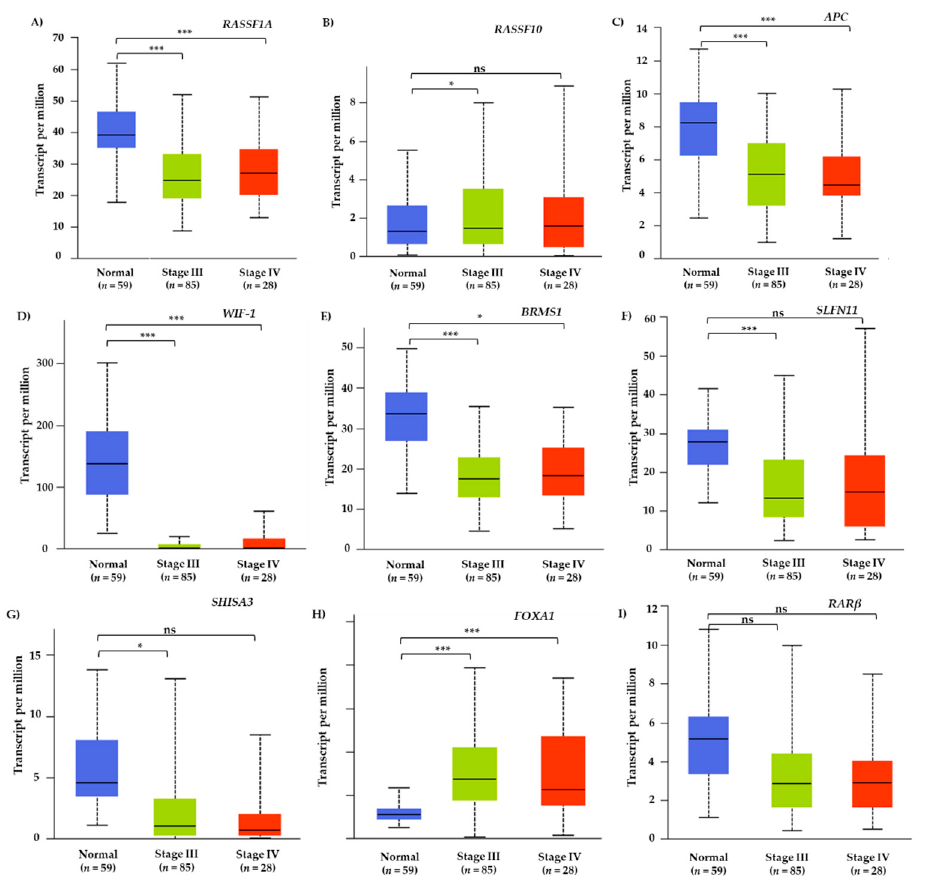
Figure 3. Gene expression levels between normal ( n = 59) and stage III ( n = 85) or stage IV ( n = 28) LUAD tissue samples for ( A ) RASSF1A , ( B ) RASSF10 , ( C ) APC , ( D ) WIF ‐ 1 , ( E ) BRMS1 , ( F ) SLFN11 , ( G ) RAR β , ( Η ) SHISA3 , ( I ) FOXA1 gene based on TCGA data from UALCAN web server (***: p < 0.001, * p < 0.05, ns: non ‐ significant).